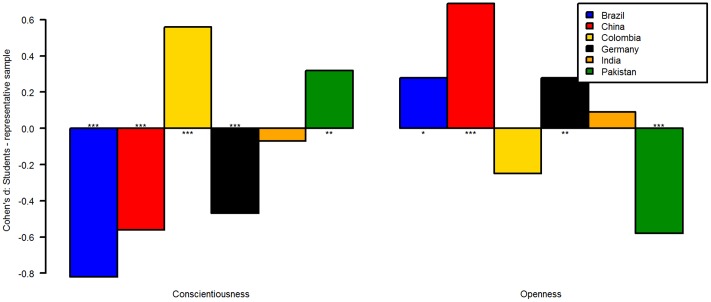
Cohen's d of student—general public comparisons for two of the Big-5 dimensions. See text for explanation.*p < .05, **p < .01, ***p < .001.